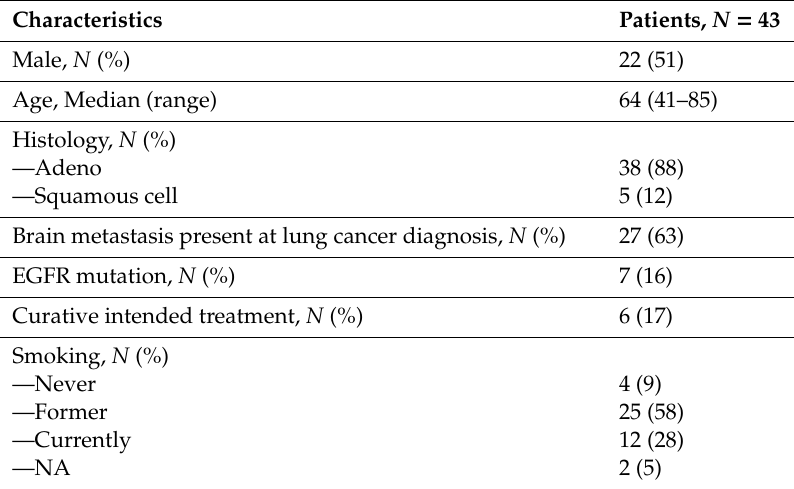
Table 1. Patient